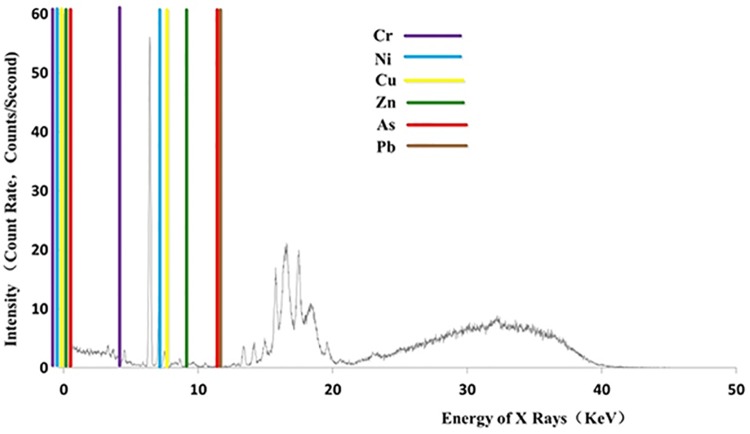
Representative soil spectrum of XRF, highlighting the qualification ranges of soil heavy metals.